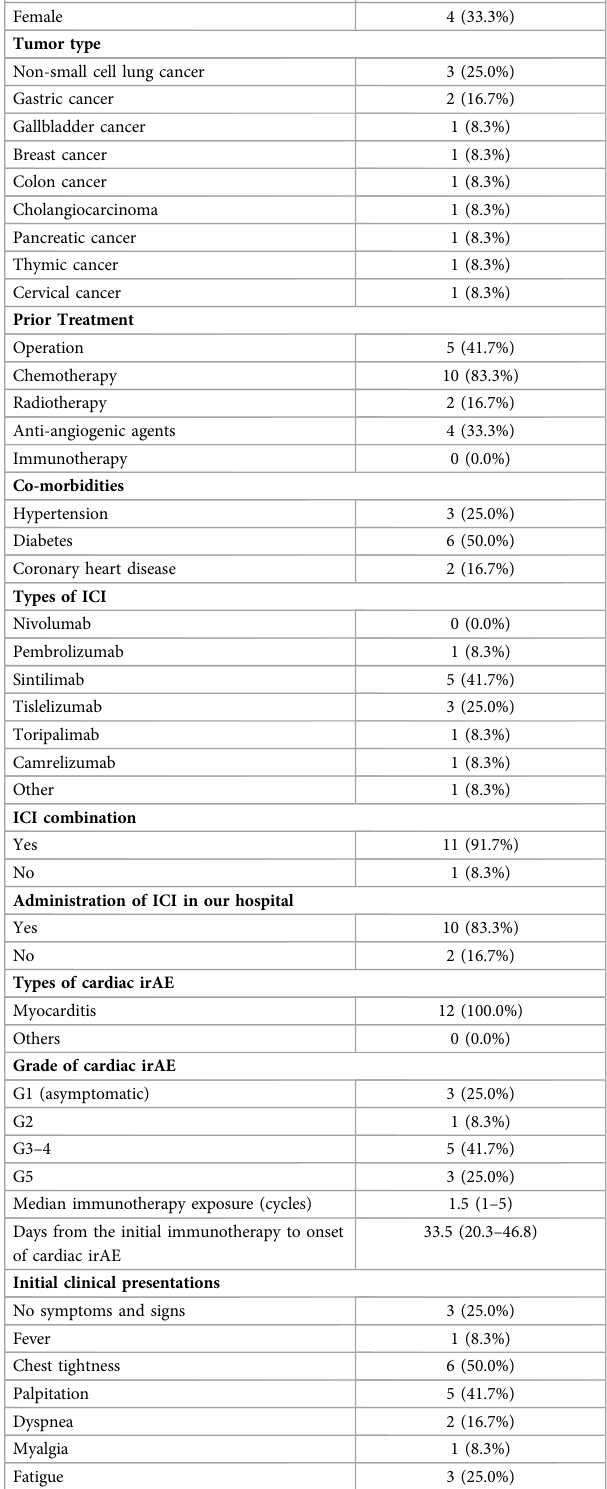
The cumulative incidence of disease progression was 58.3%, 75.0%, and 83.3% at 6 months, 12 months, and 24 months, respectively. Disease control as de fi ned by SD, PR, and CR was achieved in 8 patients (75.0%), including 7 patients with SD and 1 patient with PR ( Table 5 ). Overall, 8 patients still survive now. However, one patient with the subclinical type died of a tumor, and three patients with severe irAEs died of cardiotoxicity. The median PFS and OS for the patients with cardiac irAEs were 4.0 and 18.0 months, respectively.